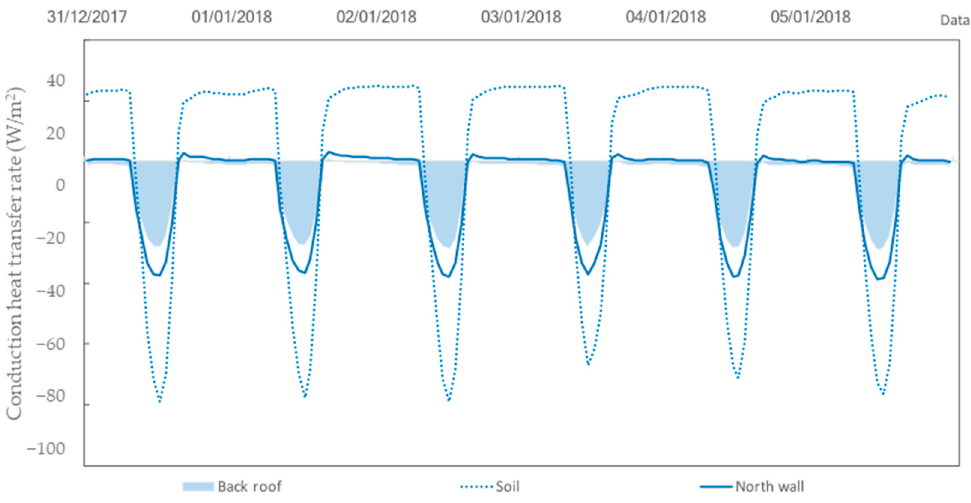
Figure 22. Conduction heat transfer on the inside surfaces of the CSG on clear days.